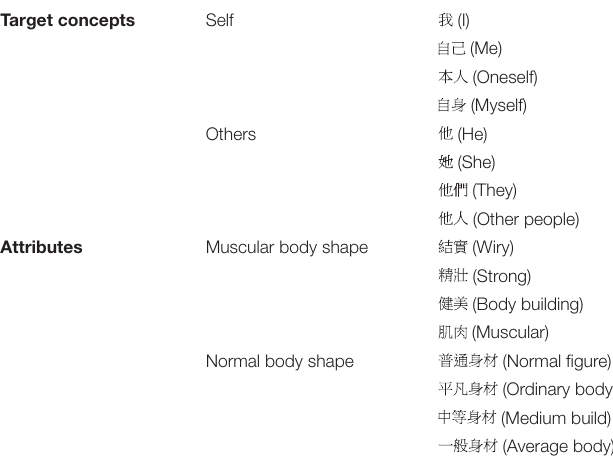
TABLE 1 | The words used for the Implicit Association Test